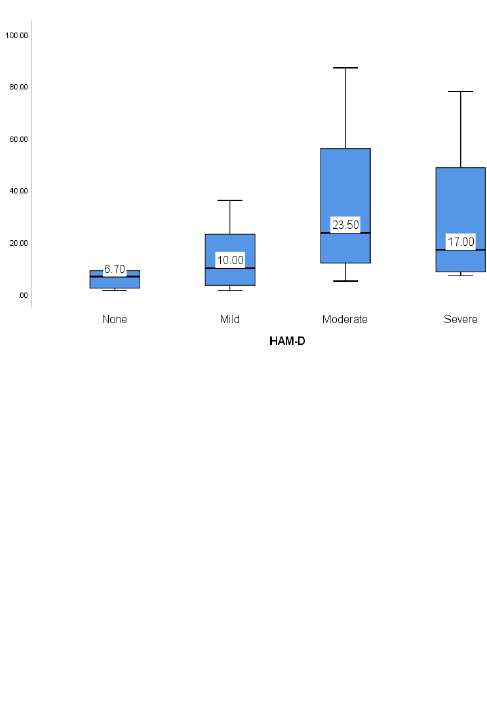
Figure 1. Biomarkers levels graphic representation based on depression categories (HAM D).